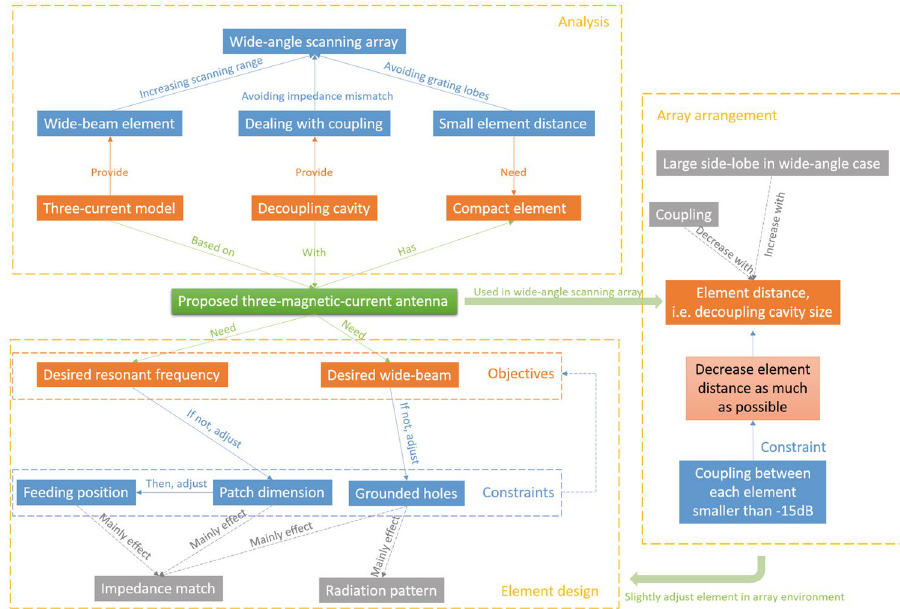
Figure 1. Design methodology of the proposed